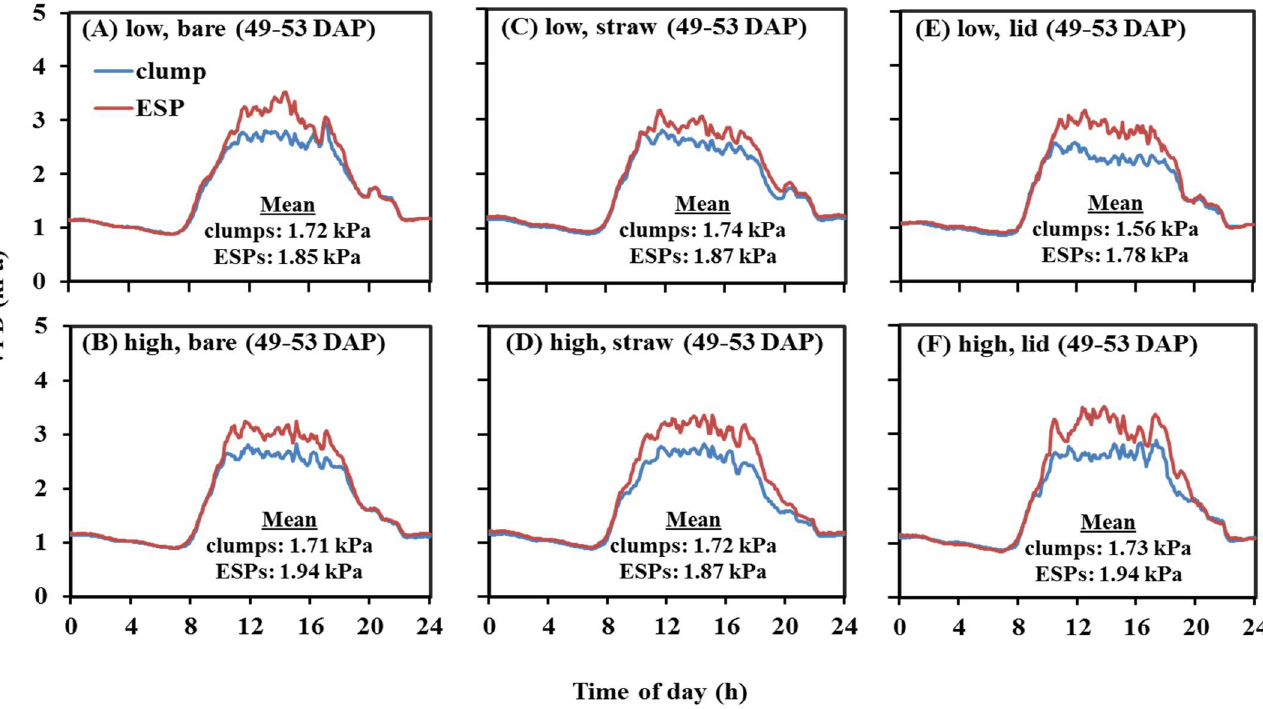
Fig 3. Average 5-day vapor pressuredeficit (VPD) mean within the plant canopy recorded everyfive minutes for different treatmentsin 2014 at 45–53 DAP corresponding to booting growth stage. DAP: days after planting;ESPs: evenly spaced plantings. The mean VPD is derived from the averageof 4320 data